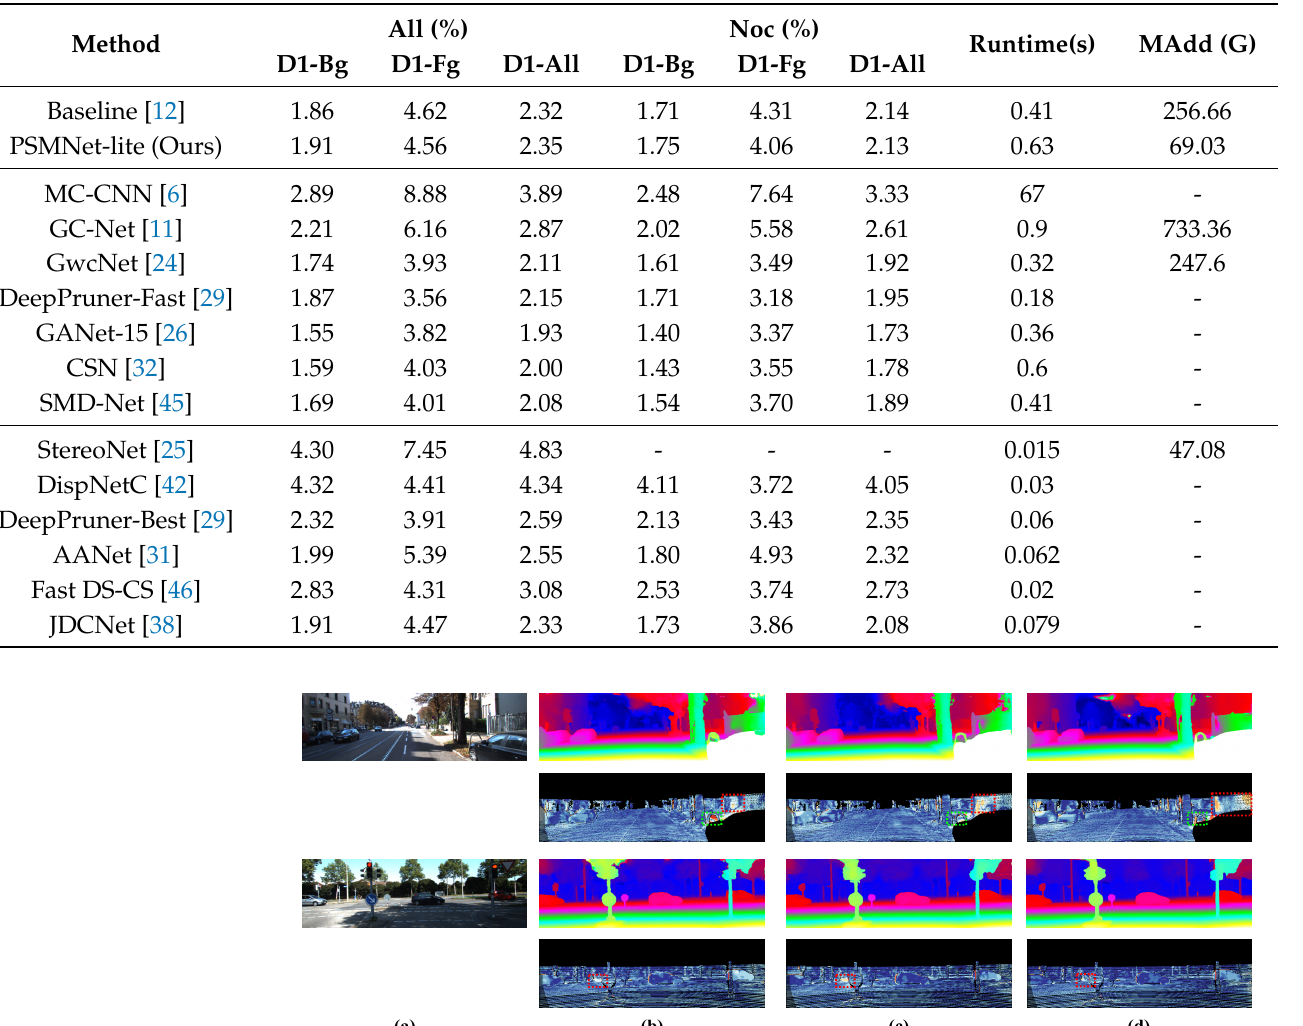
Table 5. Evaluation results on the KITTI 2015 dataset. The first seven methods are accurate methods (included the baseline). The other five are considered fast methods. Our model not only achieves results comparable to those of some accurate methods but also requires significantly less computational complexity. We only calculated the MAdd of some representative models.